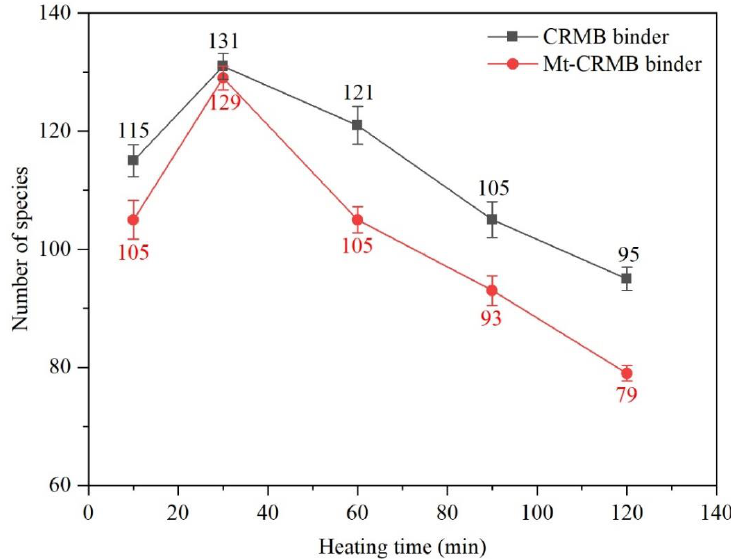
Figure 10. VOCs species number comparison between CRMB and Mt-CRMB binders at different times.